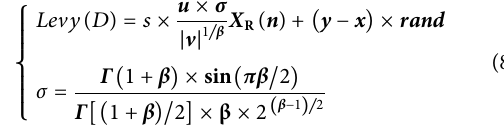
Algorithm (SCA), Slime Mould Algorithm (SMA), the AO optimizer has faster optimization speed and